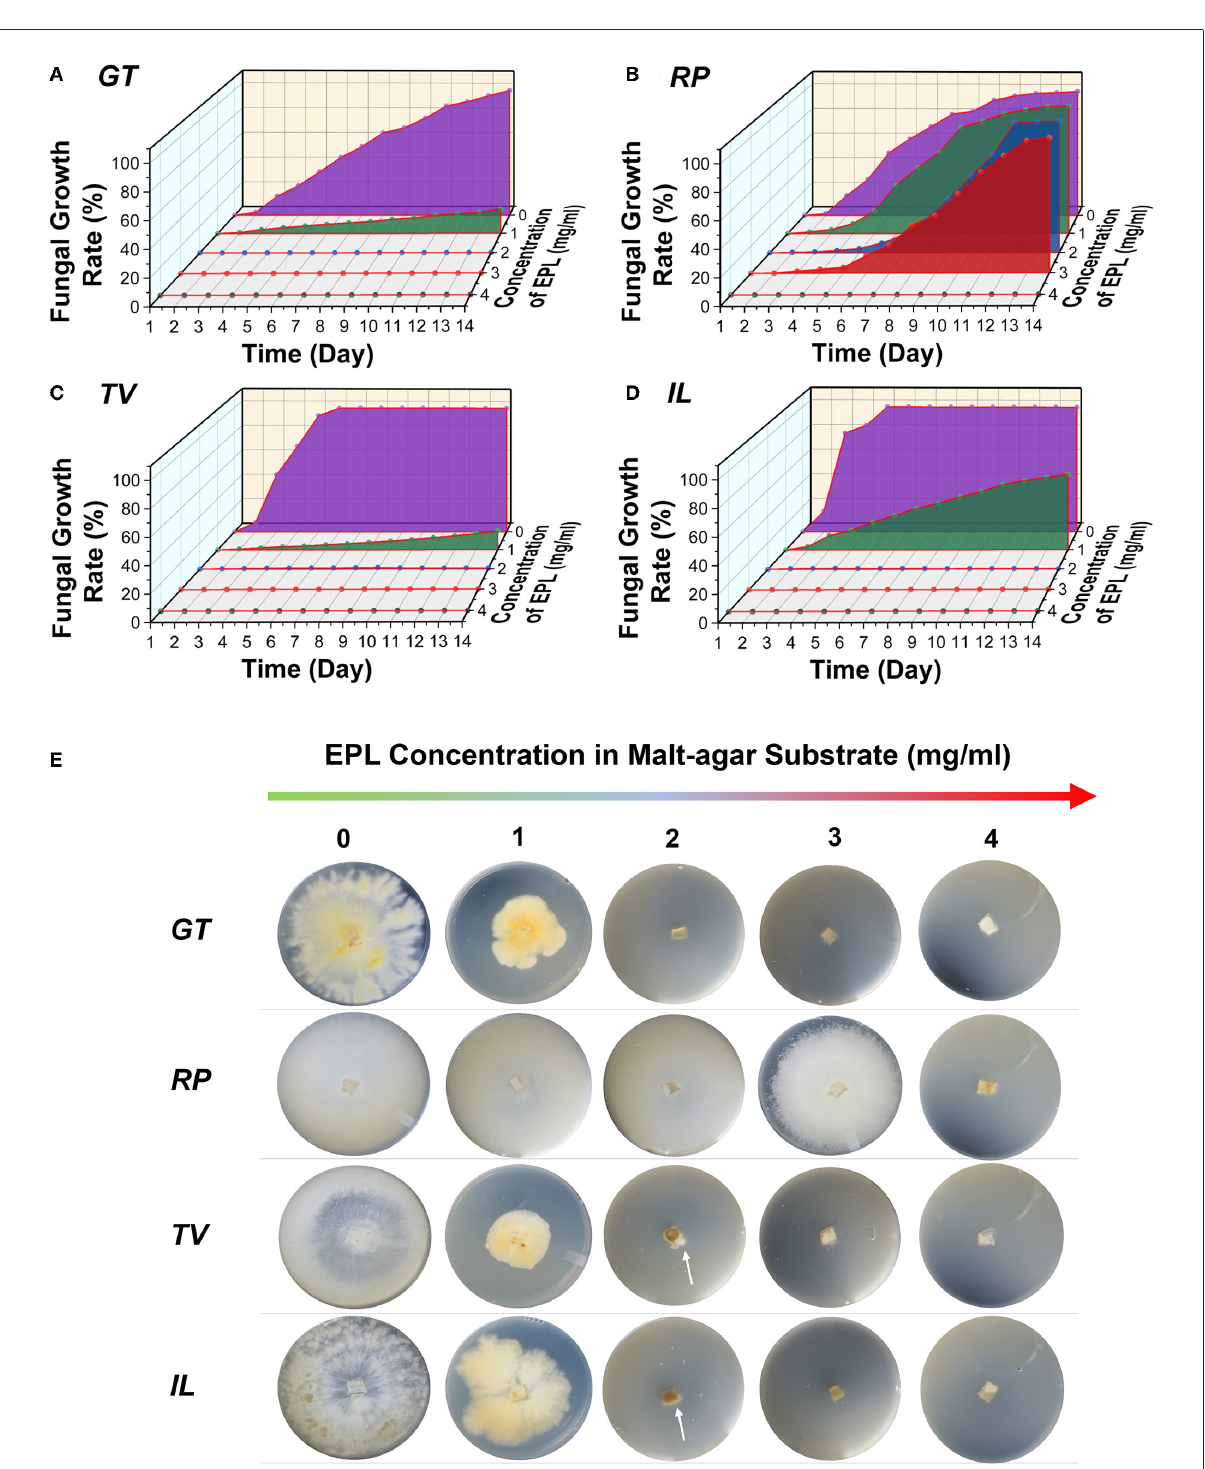
FIGURE2 Average fungal growth rates of two brown-rot fungi, (A) GT and (B) RP , and two white-rot fungi, (C) TV and (D) IL , against different concentrations of EPL in malt agar substrates over a 14-day incubation period; (E) photographs of four wood-decaying fungi grew on malt agar substrates amended with 0, 1, 2, 3, and 4 mg/ml of EPL on day 14. The arrows in the Petri dishes represent mycelia